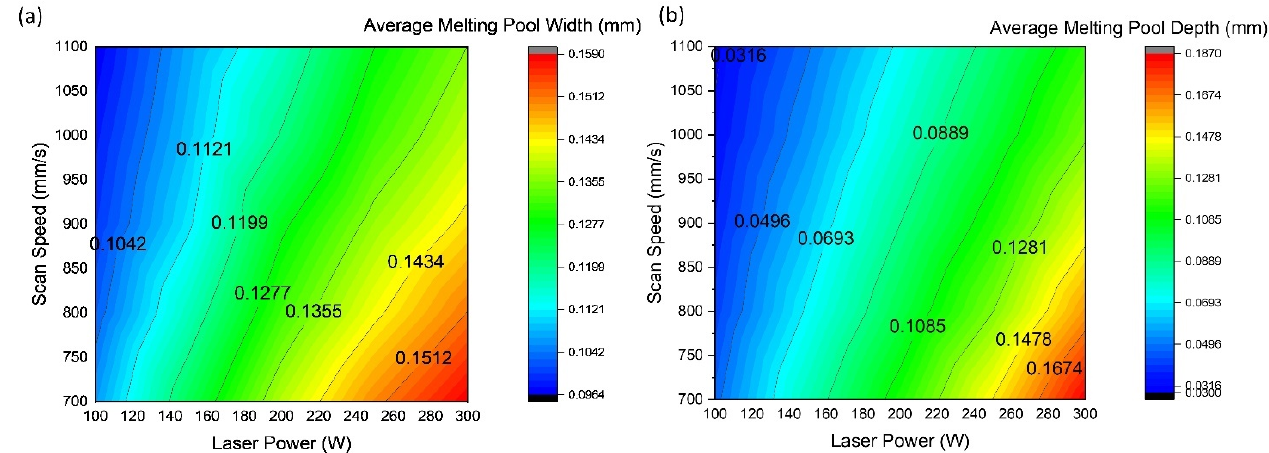
Figure 2. Calculated molten pool shape value via ANSYS Additive module: ( a ) average molten pool width, ( b ) average molten pool depth.